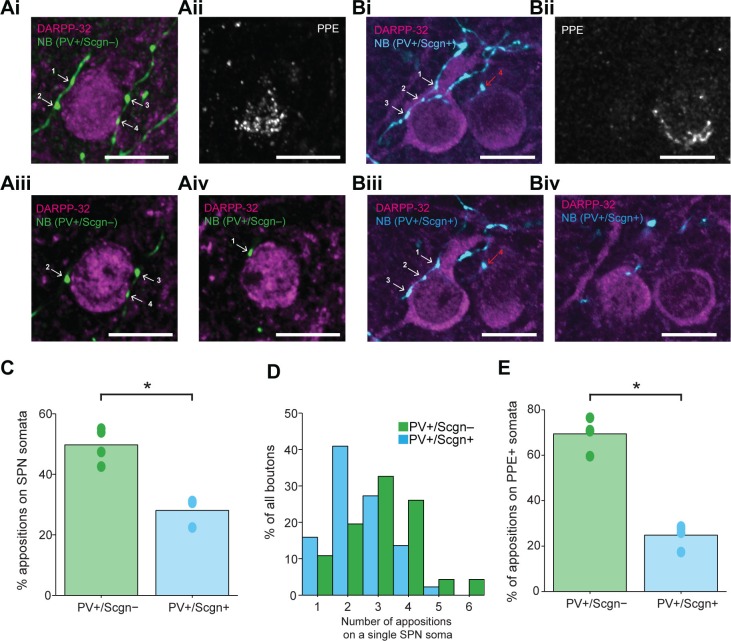
PV+/Scgn- and PV+/Scgn+ striatal interneurons selectively target the somata of SPNs in the direct or indirect pathway.(Ai) Confocal fluorescent micrograph stack of a neurobiotin (NB)-labeled axon of a PV+/Scgn- interneuron (green) targeting a SPN revealed with DARRP-32 (purple). The interneuron axon forms 4 appositions (numbered white arrows) with the SPN soma. (Aii) The SPN expresses preproenkephalin (PPE, white), indicating it is in the indirect pathway (iSPN). (Aiii, Aiv) Single-plane confocal micrographs verifying that each of the 4 boutons is closely apposed to the SPN soma. (Bi) Confocal fluorescent micrograph stack of the NB-labeled axon of a PV+/Scgn+ interneuron (blue) traversing close to two SPNs. The axon forms 3 appositions (white arrows) with the SPN soma on the left, and appears to form a single apposition (red arrow) with the SPN on right. (Bii) The right SPN expresses PPE (iSPN), while the left SPN does not, indicating it is in the direct pathway (dSPN). (Biii, Biv), Single-plane confocal micrographs verifying that boutons 1–3 are apposed to the soma of the dSPN, while bouton 4 is not directly apposed to the iSPN. (C) Quantitative analyses of the NB-labeled axonal boutons of PV+/Scgn- and PV+/Scgn+ interneurons revealed that the axons of PV+/Scgn- interneurons were more likely to be opposed to the somata of SPNs. (D) Histogram of the frequency of different numbers of appositions formed with an individual SPN soma for both types of interneuron. (E) The axons of PV+/Scgn- interneurons were more likely than the axons of PV+/Scgn+ interneurons to target the somata of PPE+ SPNs of the indirect pathway.(A,B, scale bars are 20 µm.)DOI:
http://dx.doi.org/10.7554/eLife.16088.01510.7554/eLife.16088.016Figure 8—source data 1.Source data for Figure 8C,D,E.